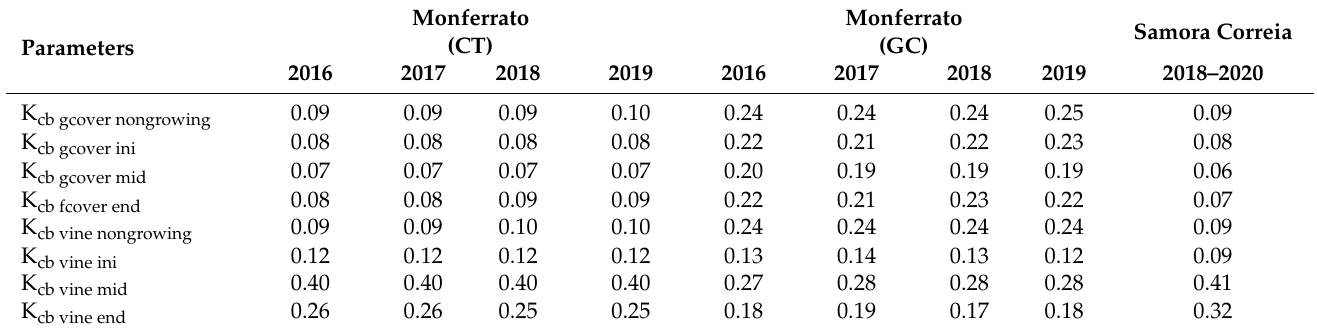
Monferrato Samora (GC)